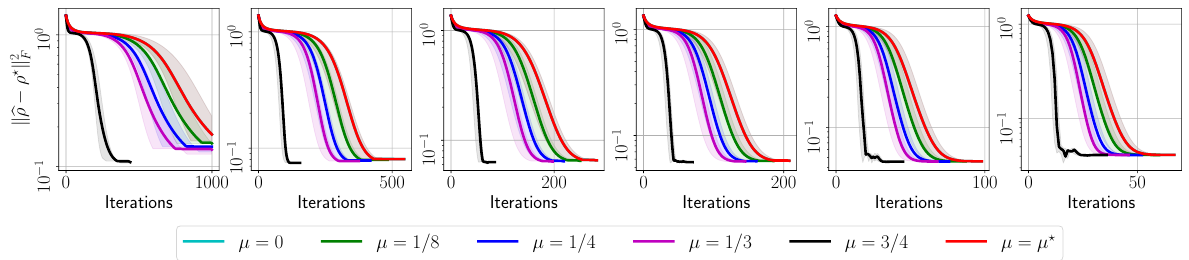
( 8 ) circuit using synthetic measurements −